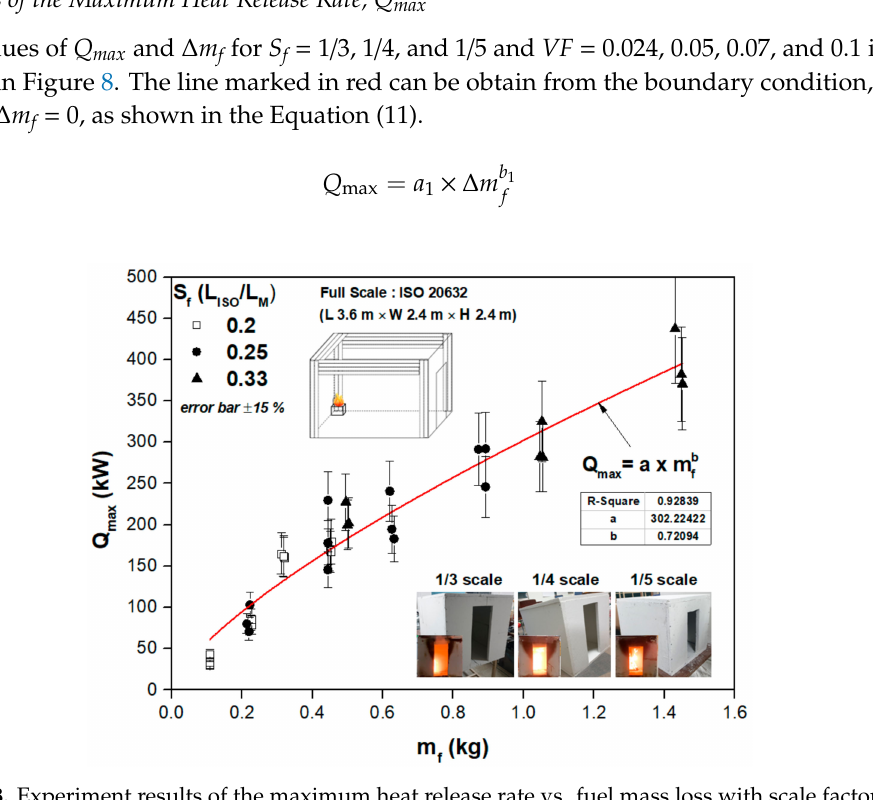
Figure 8. Experiment results of the maximum heat release rate vs. fuel mass loss with scale factors ( S f = 1 / 3, 1 / 4, and 1 / 5) and volume fraction ( VF = 0.024, 0.05, 0.07, and